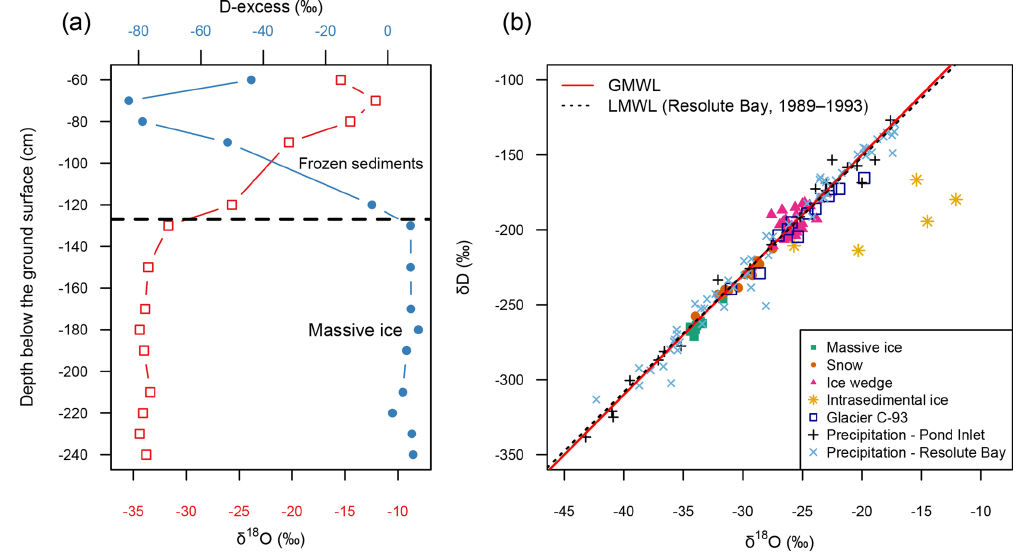
Figure 8. (a) δ 18 O and D-excess depth profiles including both the massive ice unit and the intrasedimental ice from the sediment cover; (b) δ 18 O- δ D diagram of the massive ice and other types of ground ice (ice wedge, intrasedimental ice), snow and modern glacier ice (C-93) sampled on Bylot Island. The solid red line represents the Global Meteoric Water Line (GMWL): d = δ D–8 δ 18 O + 10 (Dansgaard, 1964). Also shown are the δ 18 O and δ D values of precipitation recorded at Pond Inlet (1990–1992) and Resolute Bay (1989–1993; IAEA/WMO, 2016). LMWL is the local meteoric water line for Resolute Bay, Nunavut ( δ D = 7 . 8 δ 18 O + 5 . 33; IAEA/WMO, 2016) and Pond Inlet, Nunavut ( δ D = 8 . 0 δ 18 O + 10 . 55; IAEA/WMO,